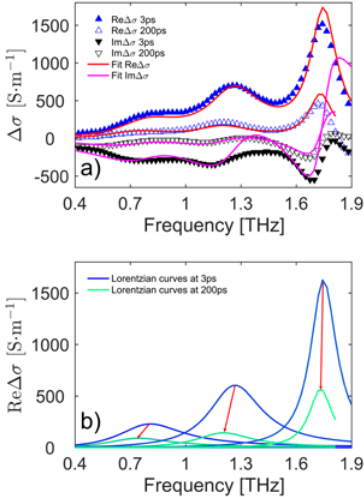
Figure 2 a) Drude-Lorentz fit of the optical conductivity at 3 (filled blue triangles and black down triangles) and at 200 ps (empty blue triangles and black down triangles); b) real part of the Lorentzian curves at 3 and 200 ps (blue and green lines respectively). Red arrows indicate the redshift of each